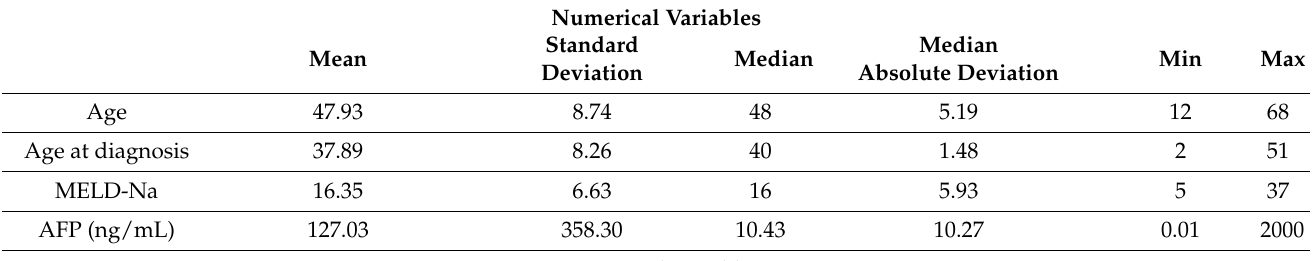
Table 1. Characterization of the numerical and categorical variables included in the training set (80